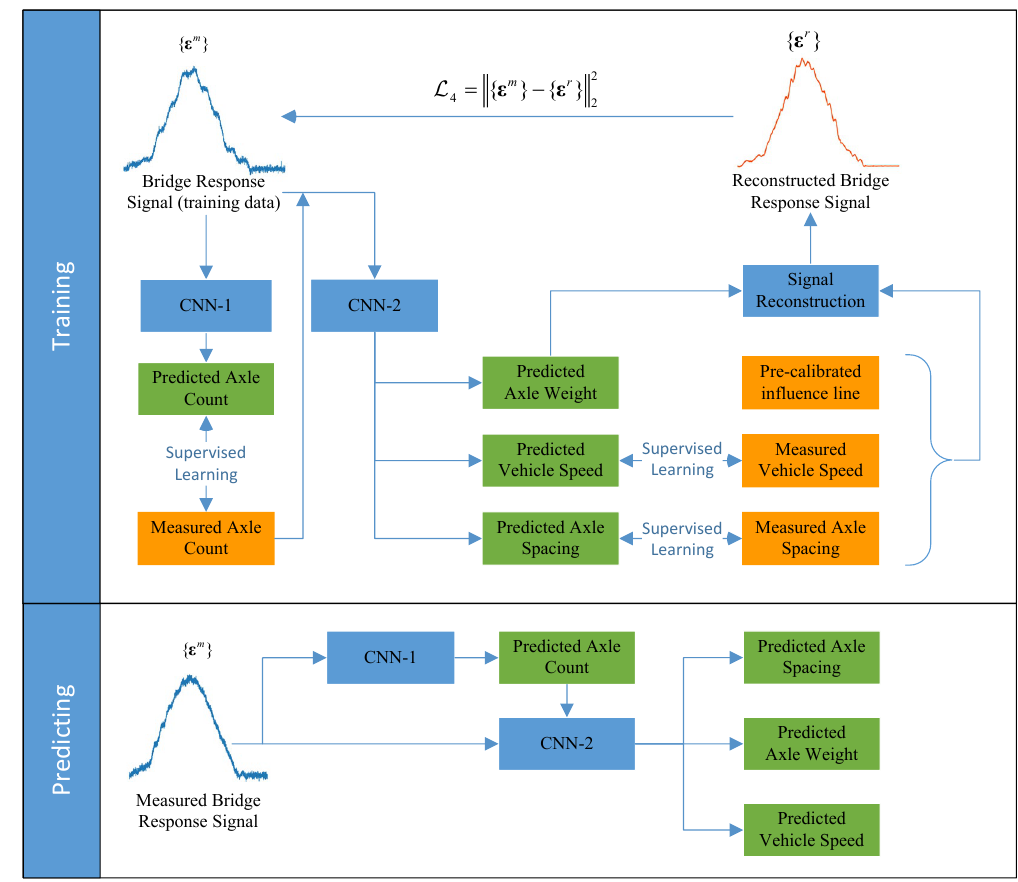
Figure 4. Framework of the proposed method. CNN-1, the neural network predicting axle count; CNN-2, the neural network predicting axle weight, axle spacing, and speed.